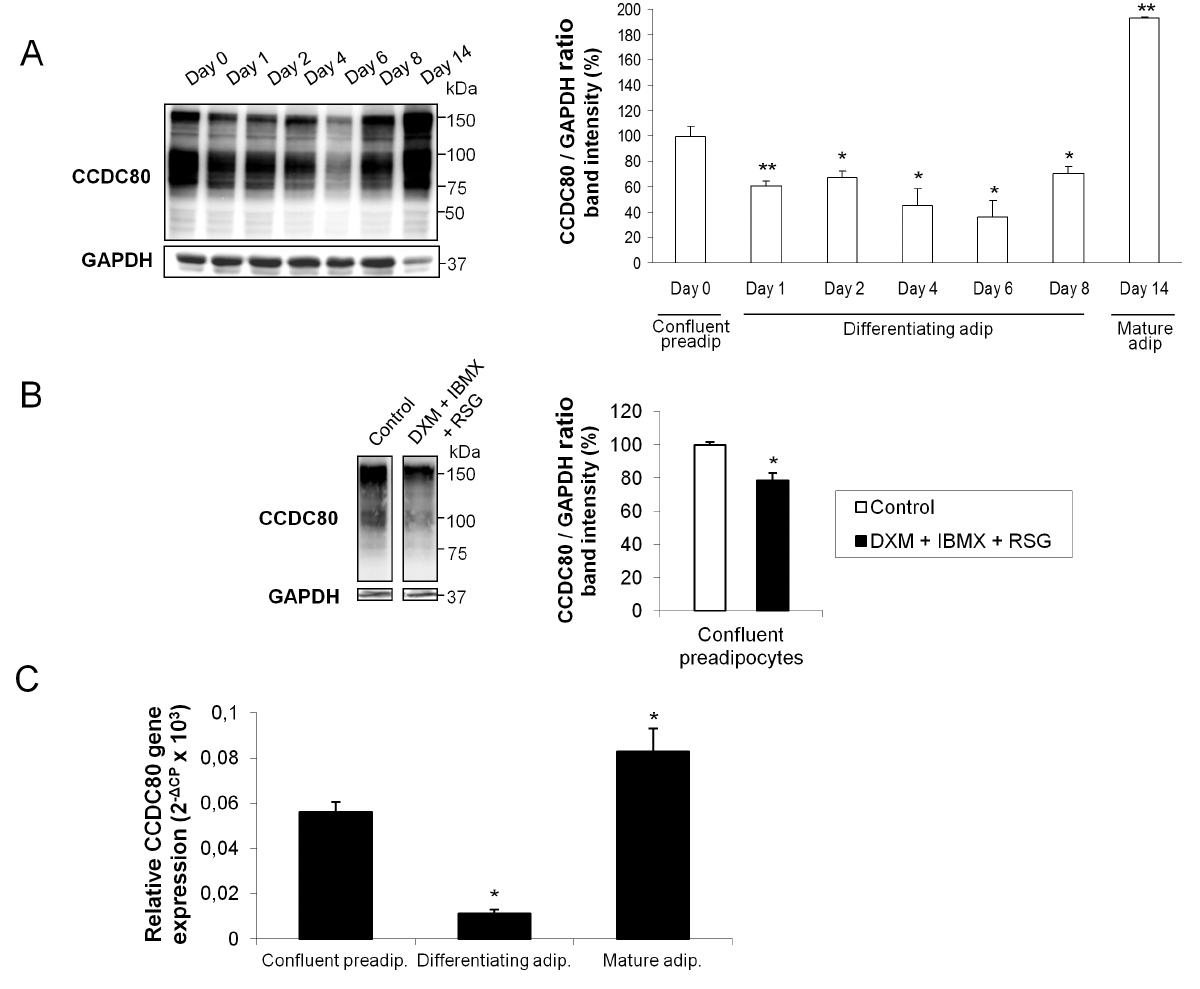
Figure 2. CCDC80 protein expression in human SGBS adipocytes during differentiation. (A) Western blot analysis of CCDC80 protein content in SGBS cell extracts of confluent preadipocytes (d 0), differentiating adipocytes (d 1–8) and mature adipocytes (d 14). (B) Confluent preadipocytes incubated with or without 25 nM dexamethasone, 0.5 mM IBMX and 2 μ M rosiglitazone for 16 h. In A and B, a representative image is shown. Ratios of intensity of CCDC80 bands compared with intensity of GAPDH are expressed as a percent- age of (untreated) confluent preadipocyte values and are means ± standard error of the mean from two experiments performed in trip- licate. * P < 0.05 and ** P < 0.01 vs untreated preadipocytes. (C) CCDC80 mRNA levels relative to 18S rRNA were measured in confluent preadipocytes, differentiating adipocytes (4 d post-differentiation) and mature adipocytes (14 d post-differentiation). Data are means ± standard error of the mean of 2 – Δ Cp × 10 3 from two experiments performed in triplicate. * P < 0.001 to preadipocytes; # P < 0.01 to differen- tiating